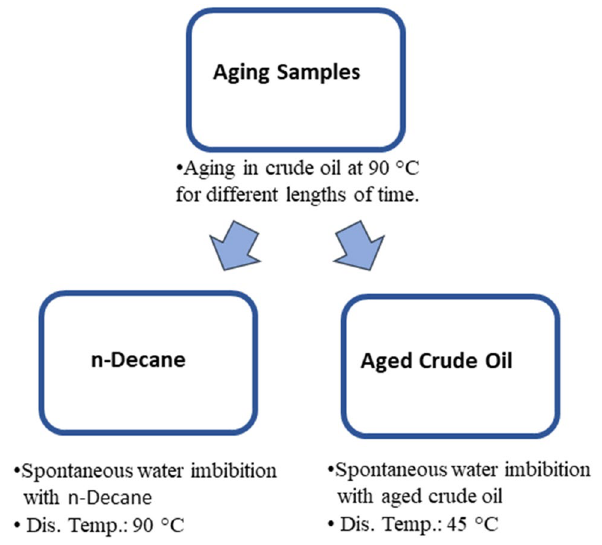
Fig. 5 Schematic diagram of the applied procedure to determine the Amott water wettability index values